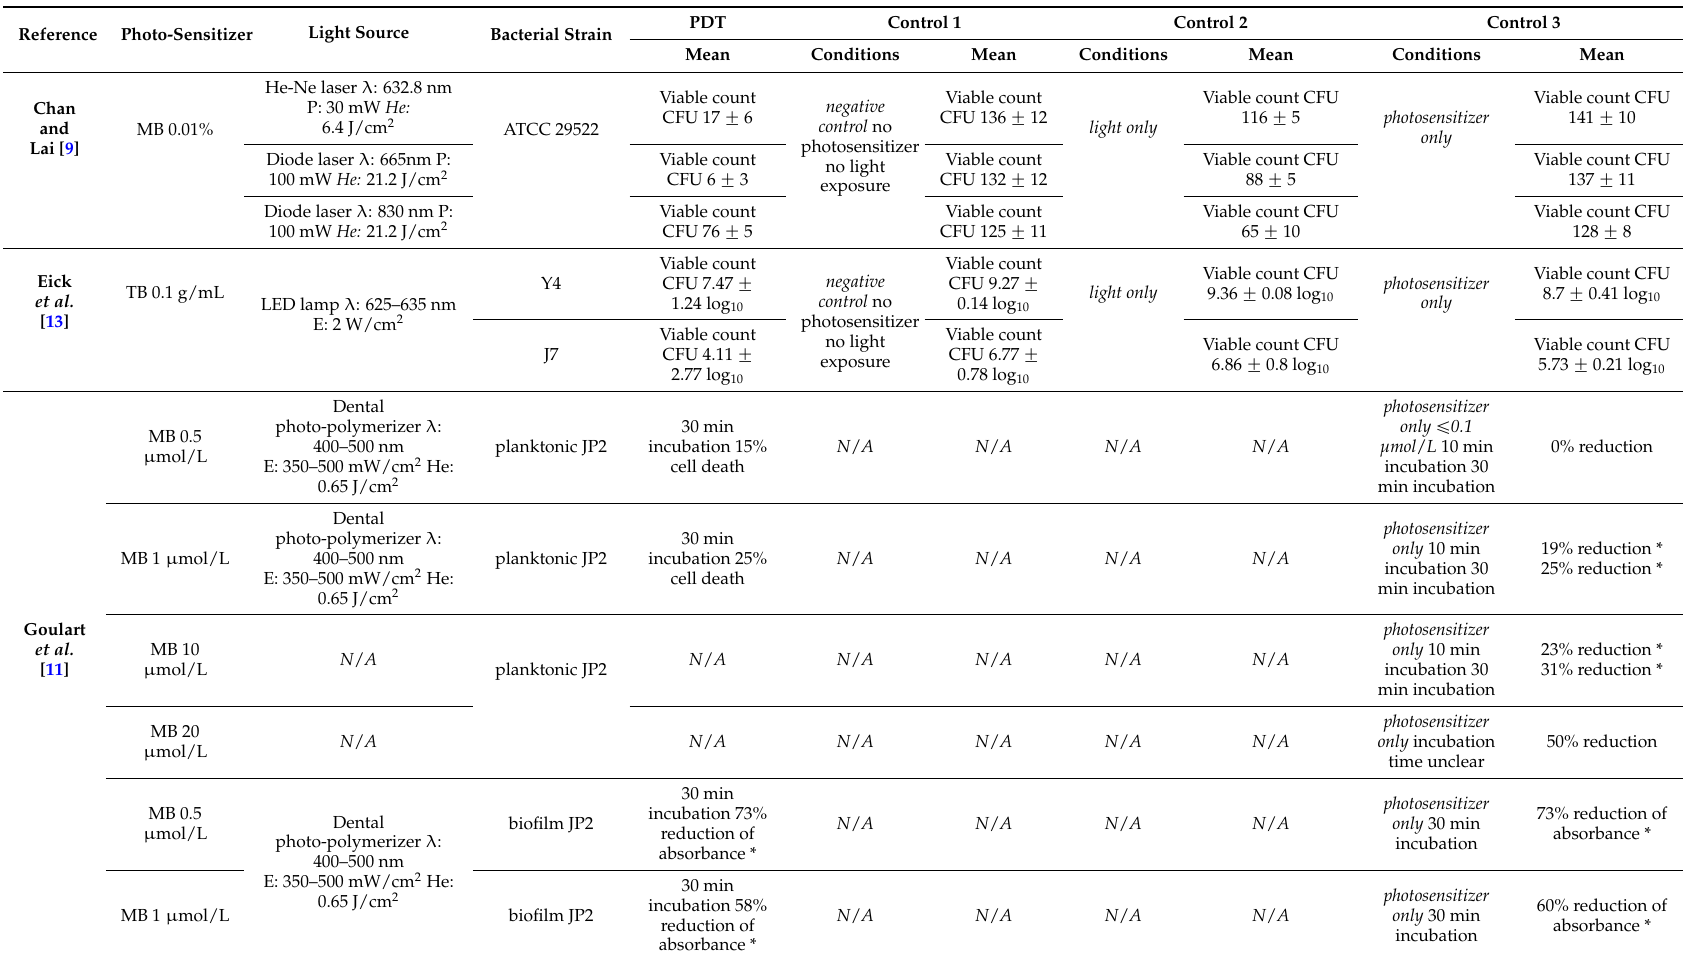
Table 2. Antimicrobial effects of photodynamic therapy (PDT) on